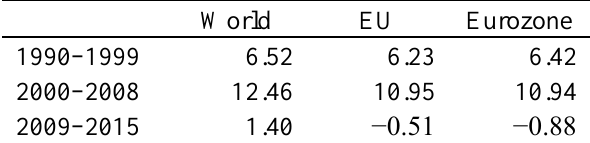
Table 1 : Annual average growth rates of exports